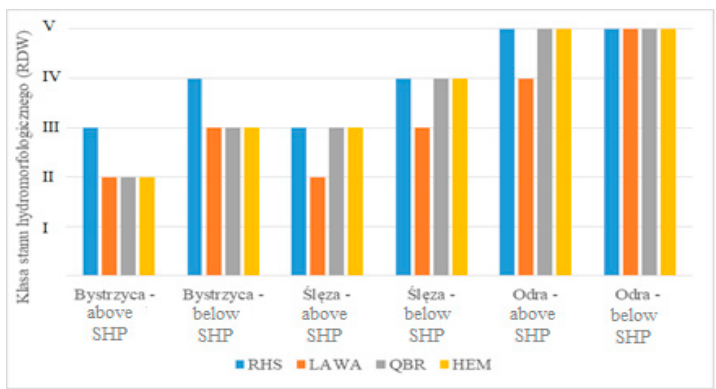
Figure 3. Hydromorphological status assessment—comparison of results using RHS, LAWA, QBR, and HEM.